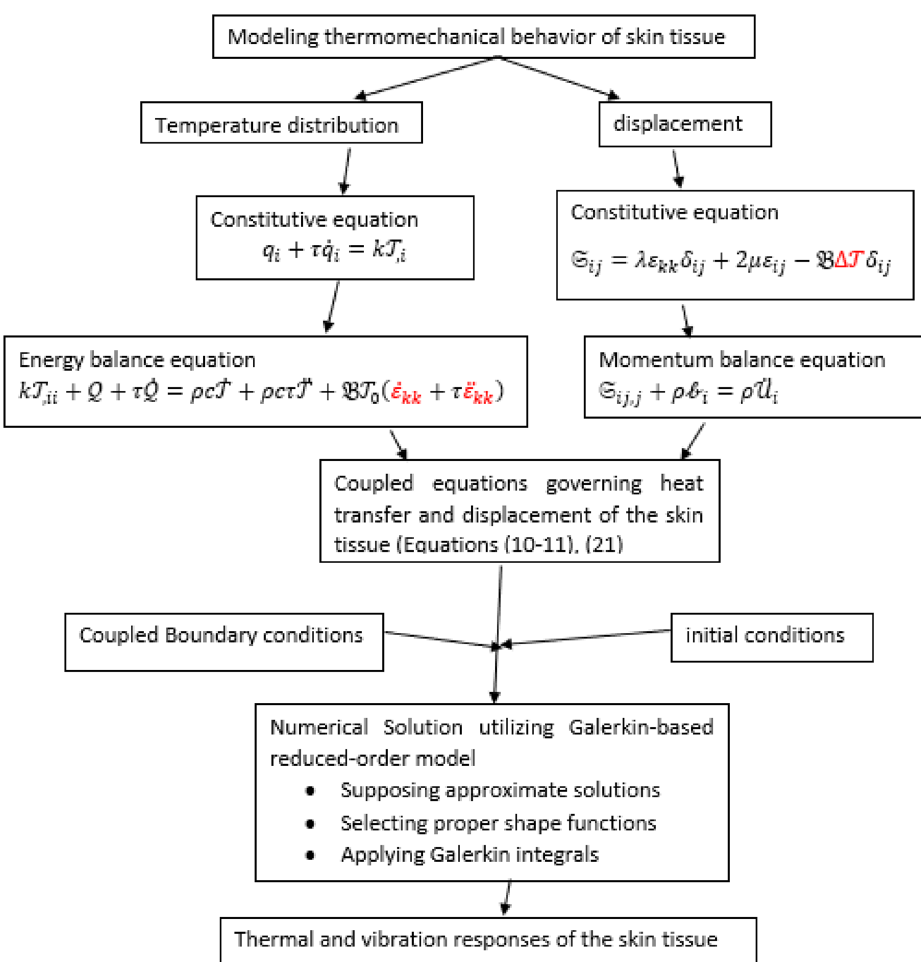
Figure 2. Flow chart of the modeling and numerical method of the